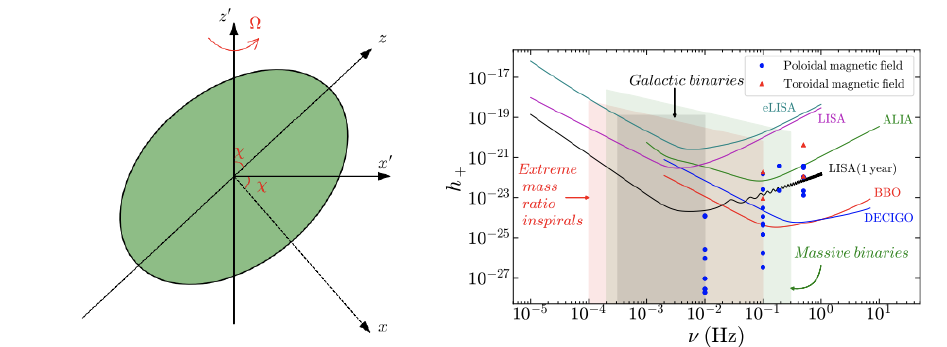
Figure 7. Left panel: Schematic diagram of a B-WD with z (cid:48) being the rotational axis and z as the magnetic axis. Right panel: The dimensionless GW amplitudes for WDs are shown as functions of frequency, along with the sensitivity curves of various detectors. Optimum i is chosen for χ at t = 0. See